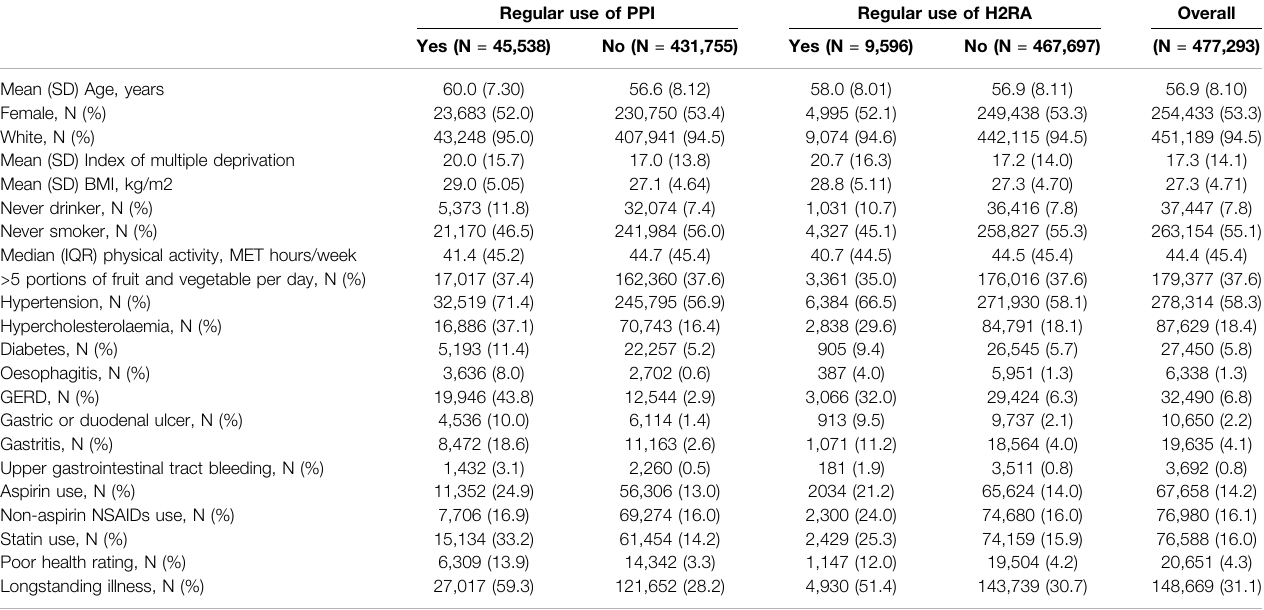
TABLE 1 | Baseline characteristics of included participants.